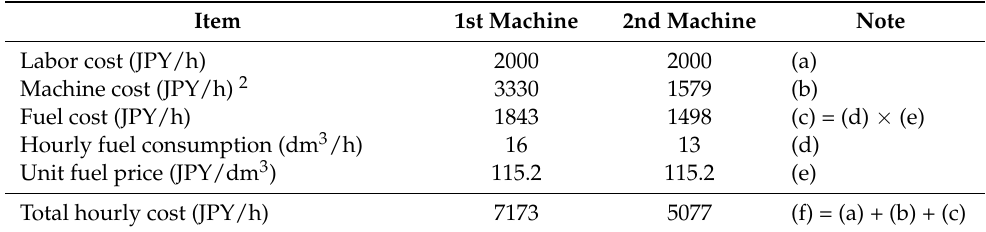
Table 4. Hourly costs of the two machines. 1.